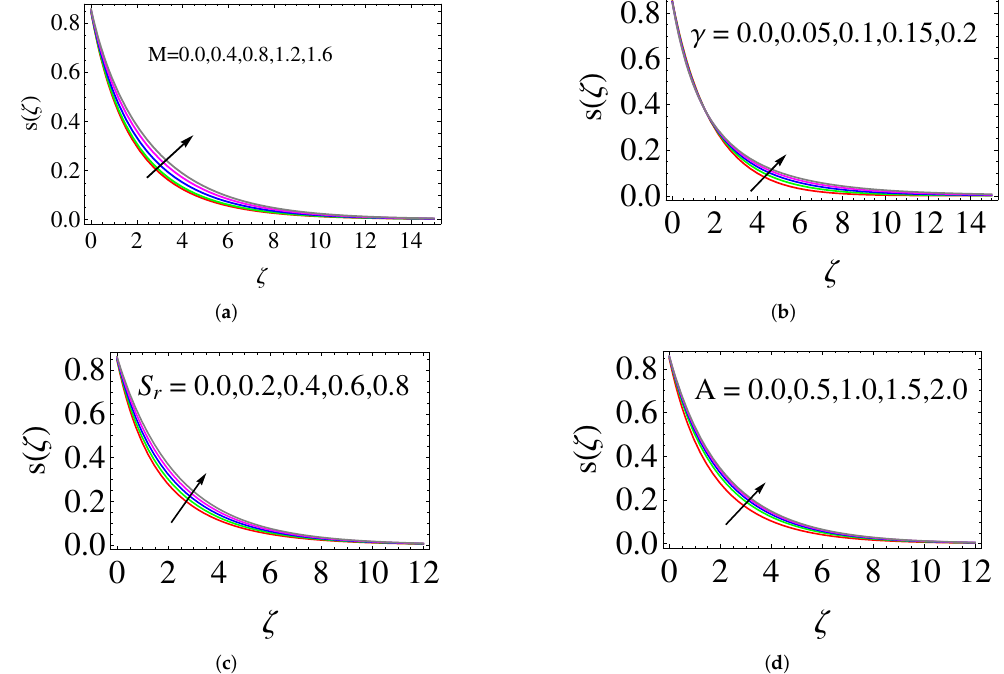
Figure 7. Influences of ( a ) magnetic ( M ) , ( b ) curvature ( γ ) , ( c ) Soret number ( S r ) and ( d ) velocity slip ( A ) parameters on concentration profile for Rd = 0.1, Nt = 0.1, θ w = 0.1, Nb = 0.1, Pr = 1.4, D f = 0.2, Sc n = 1.9, Sc = 0.4, C r = 0.1, G 1 = G 2 = G 3 = 0.1 and B 1 = B 2 = B 3 = 0.1. The regression equation for skin friction with A , γ and M for 0.1, 0.2, 0.3, 0.4 and 0.5 are